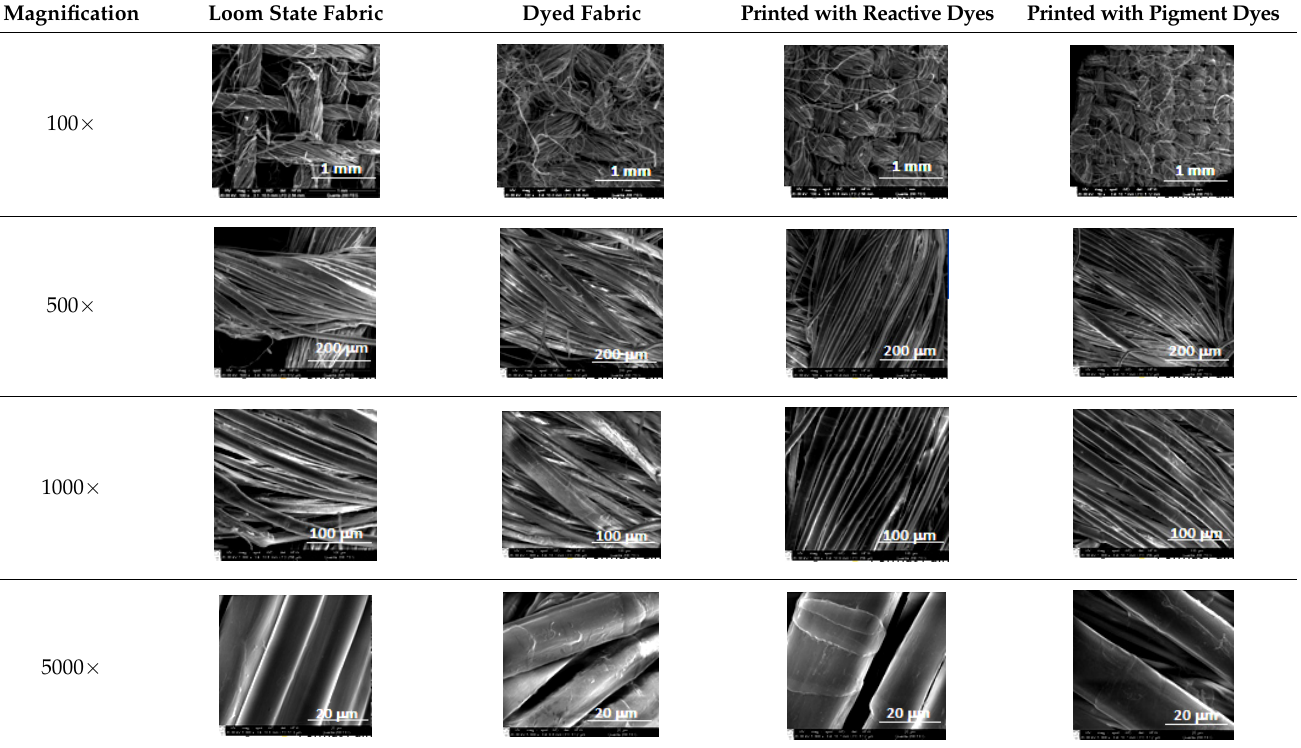
Both for dyed and printed fabrics, the issue of the properties of color fastness against various impacts is of high relevance (see Table 2). The measurement was conducted by employing the grayscale. Both measurement methods, by grayscale and by spectropho- tometer, are used for the evaluation of color fastness [16], but the first method predomi- nates in the analyzed scientific literature. Therefore, this method was chosen for our re- search. All scores except for wet friction were assigned high grades, i.e., all samples were given grade 5. The results show that the quality of finishing, especially dyeing and scour- ing, is high, because different impacts do not influence the color fastness of the investi- gated fabrics. Thus, it can be explained by good dyestuff fixation during dyeing, printing, and scouring. These results are positive because poor fastness relative to water, perspira- tion, and friction causes dye migration, which results in irritation and another negative impact on human skin [2]. The research data correspond to the data in references [11–13], which state that different forms of textile cleaning and softening methods do not worsen color fastness. The results also correspond to the references [11,20], which established that excellent color fastness is characteristic of both cellulose and protein fibers. The only dif- ference was found for wet friction, which was assigned grade 3 for dyed and softened fabric, whereas fabrics printed with pigment and reactive dyes received grade 4. Color fastness also shows the quality of finishing, especially for dyeing and rinsing, because by choosing the correct dyeing process parameters, we can achieve low dye migration and rapid wear [8].